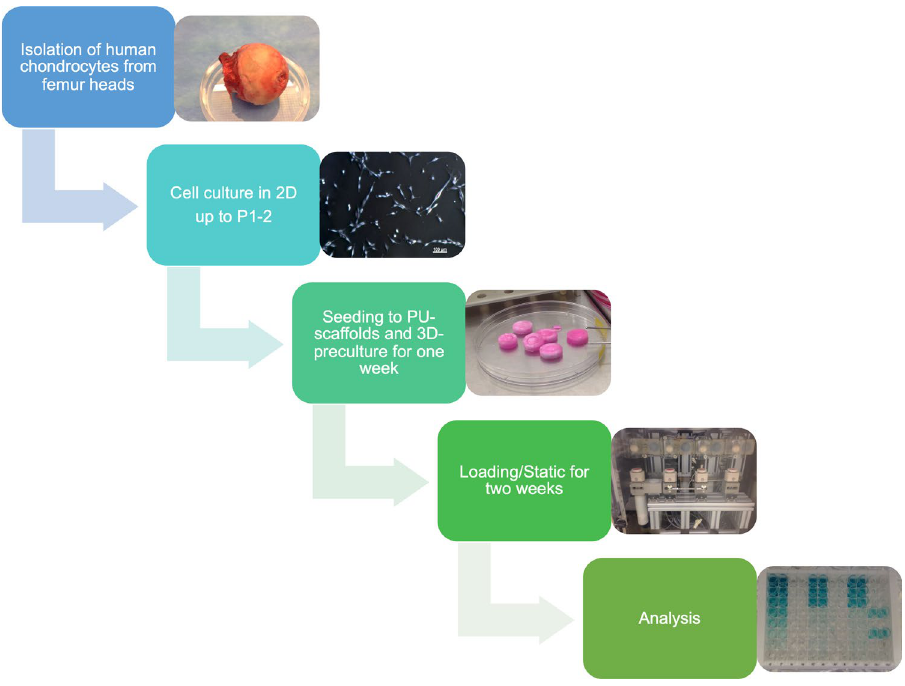
Figure 1. Experimental